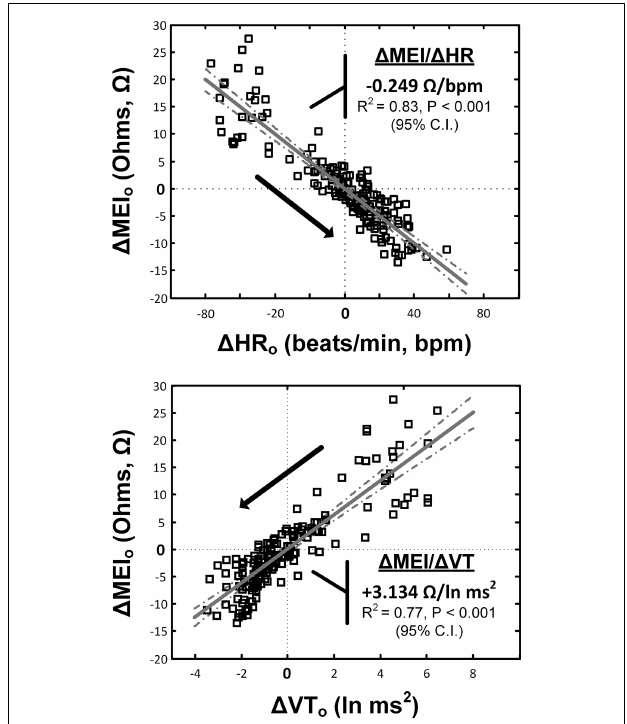
FIGURE 3 | Relationship(s) between the exercise-induced changes in the heart-rate (top) and ECG-derived vagal-tone index (bottom) with the concomitant reductions in myocardial electrical impedance (MEI); relationships were “centered,” i.e., deviations from each animal’s mean values (over the whole exercise bout) were studied.